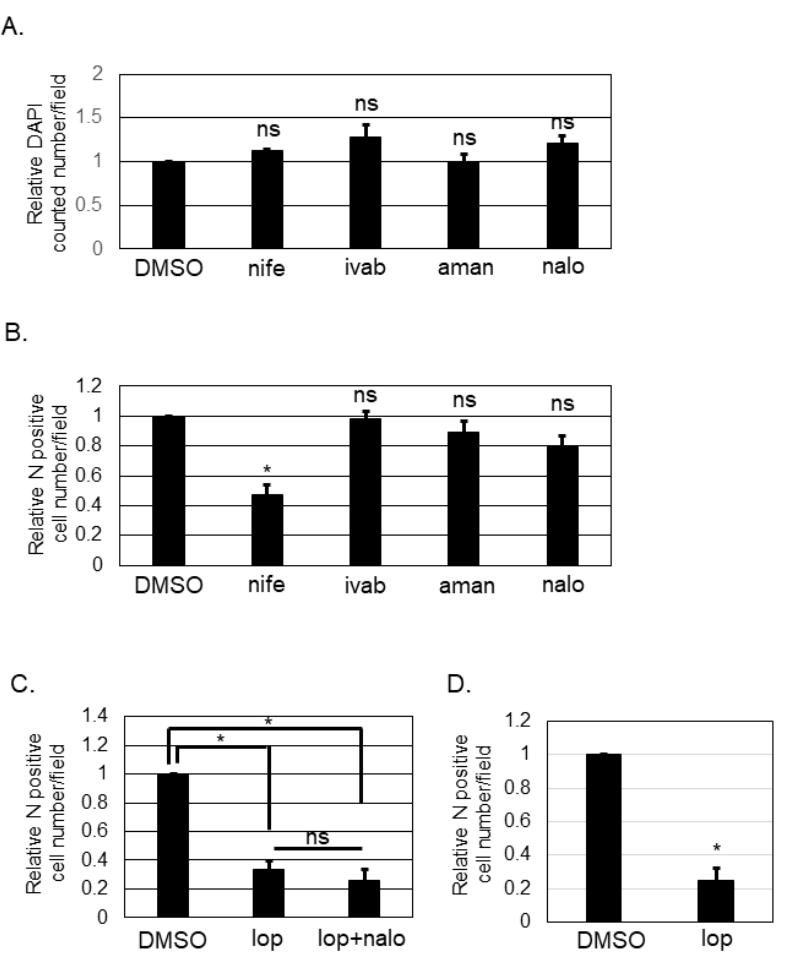
Figure 3. Identification of the mechanism of action of loperamide on the post-entry step of SFTSV infection. ( A ) Relative DAPI-positive cell numbers upon nifedipine (nife, 250 µ M), ivabradine (ivab, 250 µ M), amantadine (aman, 625 µ M), or naloxone (nalo, 1 mM) treatments compared to DMSO treatment, in Huh-7 cells at 24 h post-treatment. ( B ) Relative SFTSV N-positive cell numbers per field at 16 h p.i. in Huh-7 cells. ( C ) Relative SFTSV N-positive cell numbers per field upon DMSO, loperamide (lop, 20 µ M), or lop (20 µ M) with nalo (1 mM) treatment at 16 h post-treatment. ( D ) Vero 76 cells were infected with SFTSV and treated with either DMSO or loperamide (20 µ M). Relative N-positive cell numbers per field at 24 h p.i. were shown. Data correspond to the mean ± SD (ns; not significant, * p <